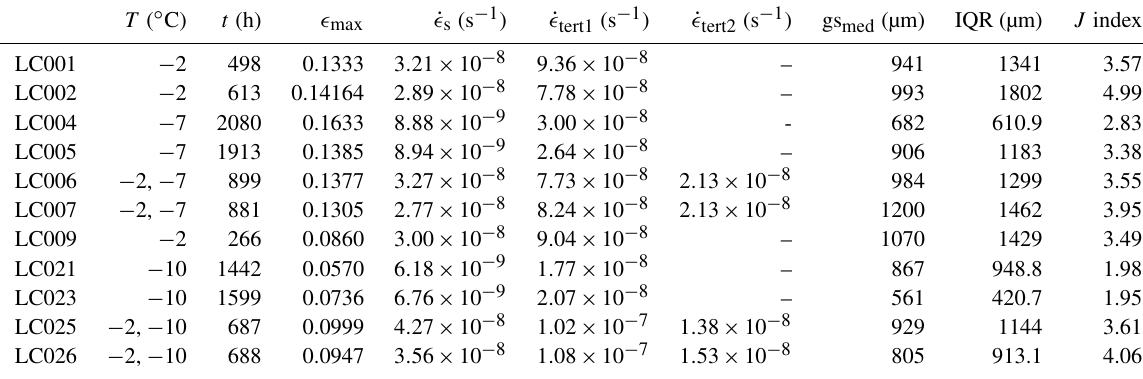
Table 1. List of all experiments performed, along with their starting parameters, measured strain rates, and microstructural properties. t is the total experiment run-time excluding set-up and decommission, (cid:15) max is total accumulated strain, ˙ (cid:15) s is the secondary strain rate, ˙ (cid:15) tert1 and ˙ (cid:15) tert2 are tertiary strain rates measured at the first and second (if applicable) temperatures respectively, gs med and IQR are the median value and interquartile range of the measured grain sizes after deformation, and J index is a measure of c -axis orientation density as described by Bunge